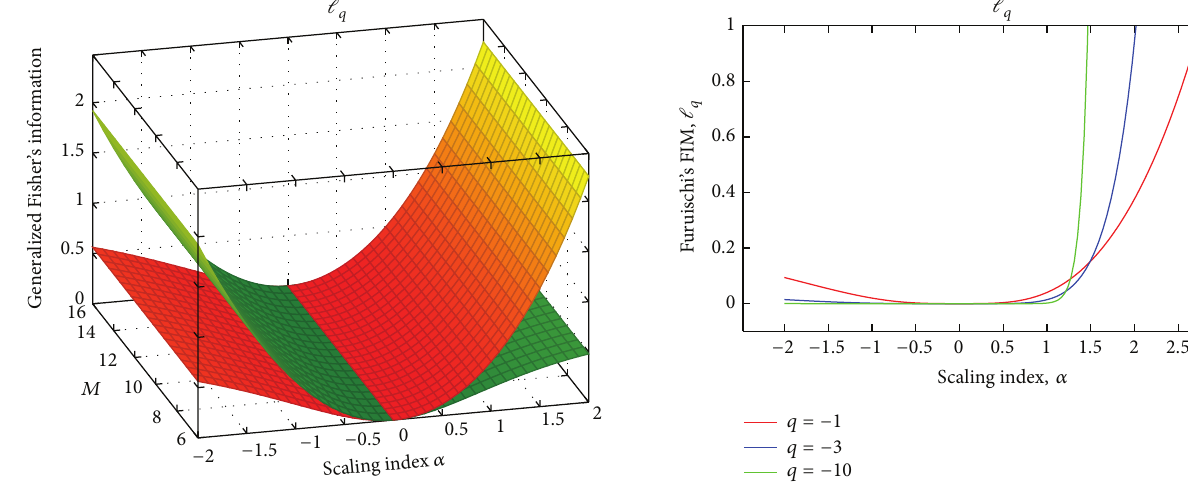
Figure 3: Comparison of standard wavelet Fisher’s information (red-yellow plane) with generalized wavelet Fisher’s information for 𝑞 → 1 (green plane).